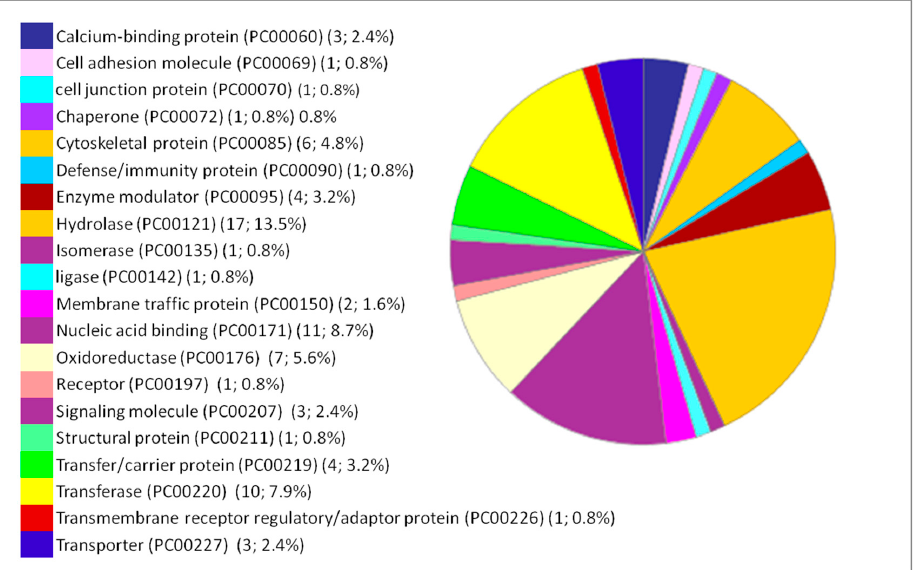
Figure 4. Functional classification of the 127 differentially expressed proteins in the brain following IONP exposure according to PANTHER protein class. The pie chart was generated from PANTHER Classification System. The number and percentage are given based on the 127 proteins. Protein name (Protein class PC) (Number of proteins; percentage from the 127 proteins).